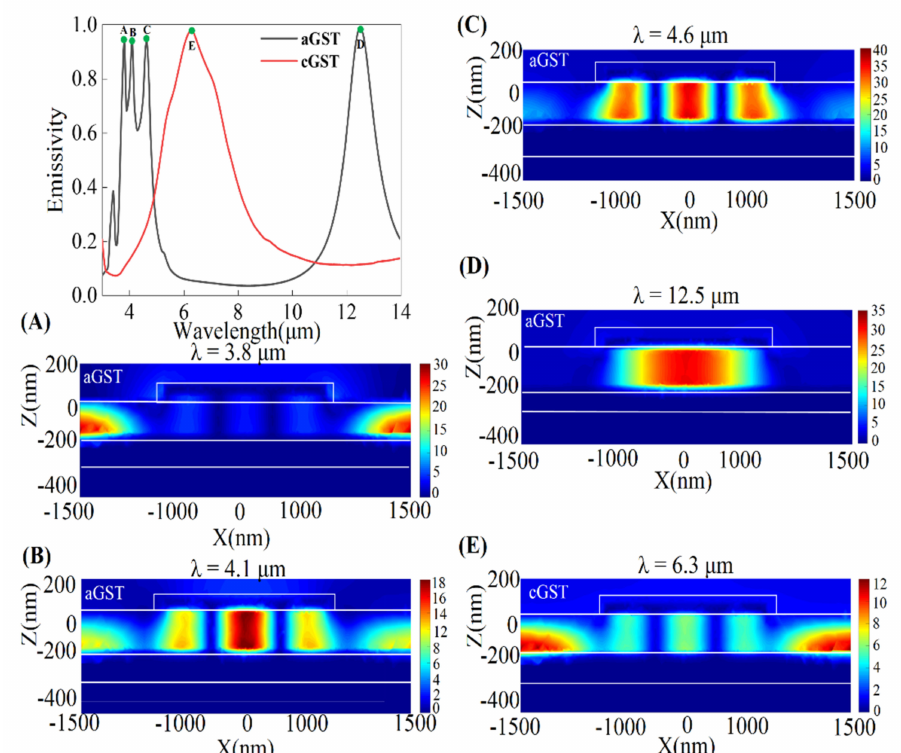
Figure 2. Simulated spectral emissivity of the tunable MIM thermal emitter is obtained when crystallization fraction of GST is 0% and 100%, respectively. The black and red lines represent the aGST-Emitter and cGST-Emitter, respectively. ( A – D ) represent the enhancement of magnetic field intensities component |Hy| of the peak length of different resonant modes of the aGST-Emitter. The color-map ( E ) represents the enhancement of magnetic field intensities component |Hy| of single peak length of the